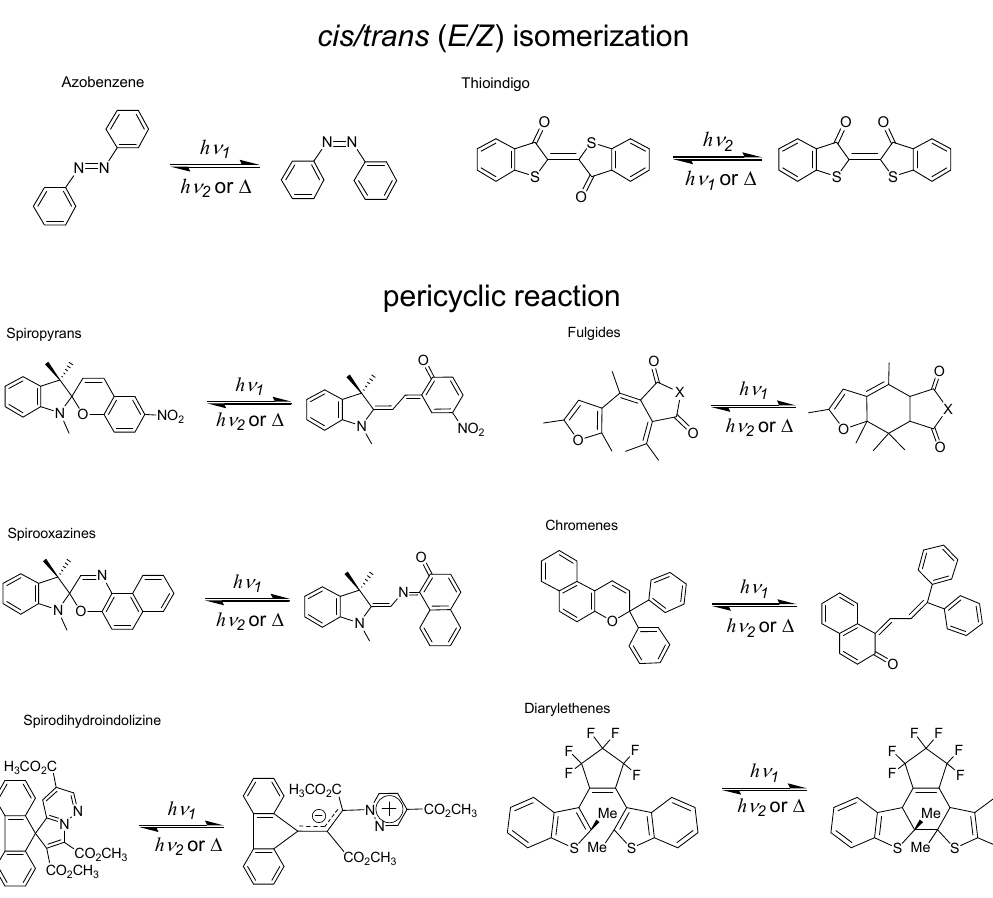
Scheme 6. The two types of mechanism in photochromic